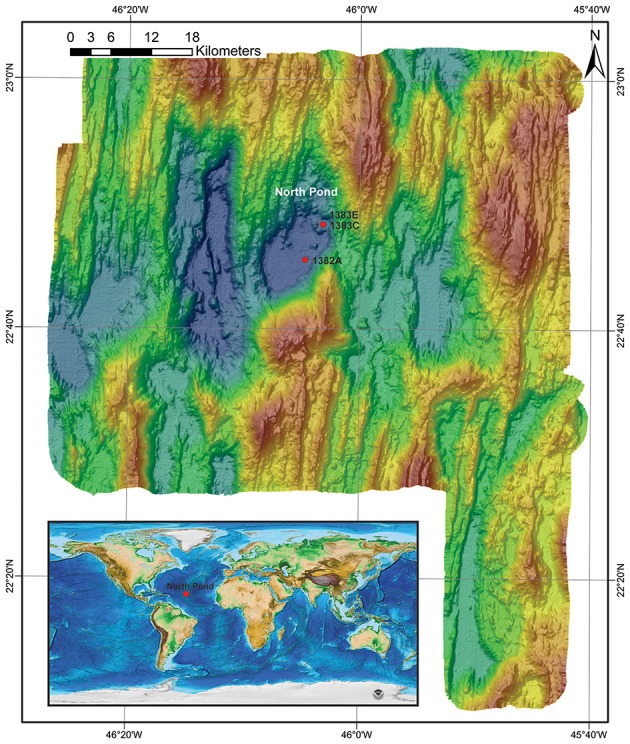
Bathymetric map with the location of the investigated sites. Red circles indicate the geographic location of the investigated sites. Insert: global map indicating the position of North Pond in the Mid-Atlantic Ocean (Source: National Centers for environmental Information - NCEI). Modified from Bach (2012).